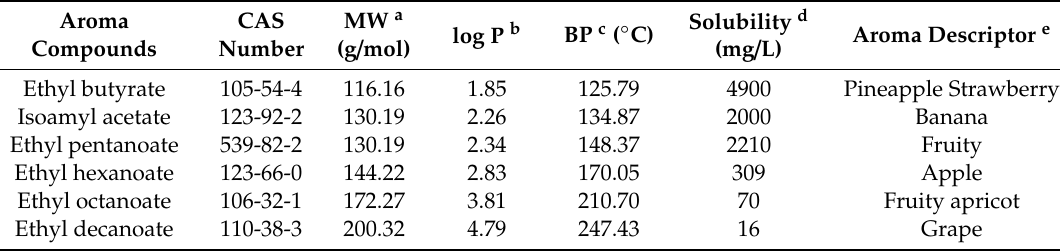
Table 1. Physicochemical properties of the aroma compounds employed in this study.